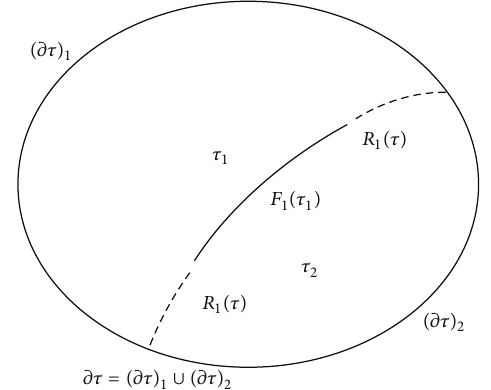
Figure 2: The macroscopic continuum region 𝜏 containing two subsystems 𝜏 1 and 𝜏 2 interacting on the surface 𝐹 1 (𝜏) of the tangential jump of the continuum velocity.